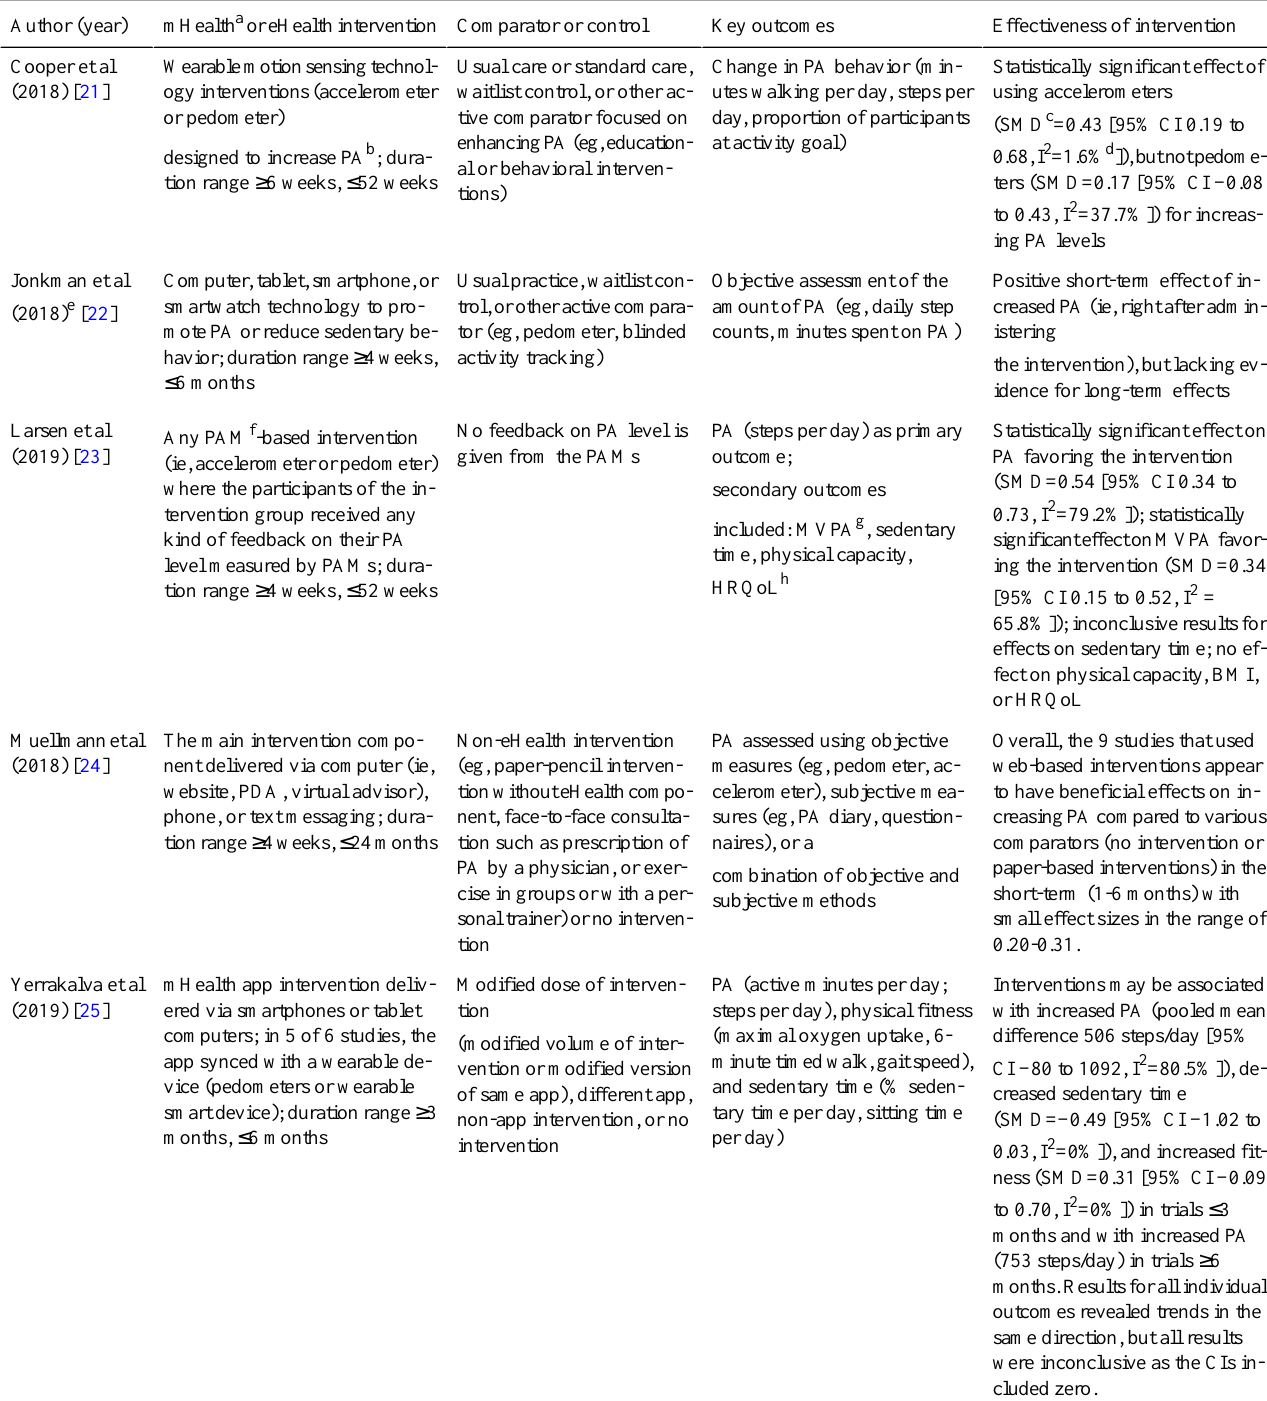
Table 2. Summary of review interventions, comparators, outcomes, and conclusion regarding intervention